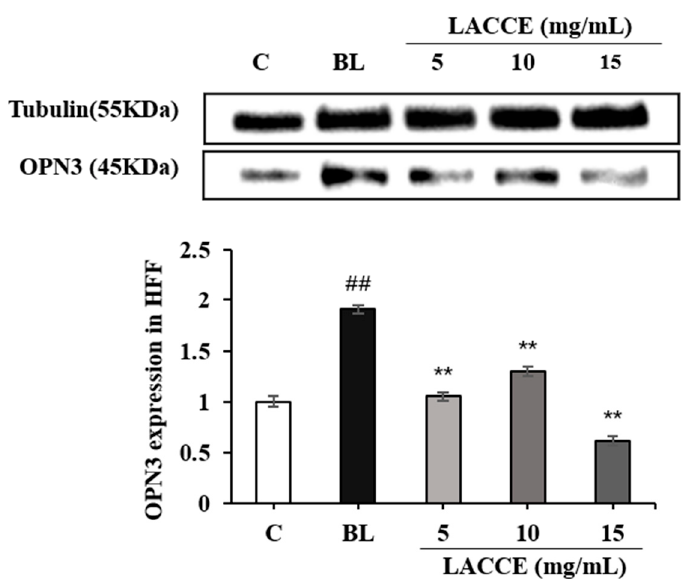
Figure 8. Effects of different concentrations of LACCE on OPN3. The data are expressed as mean ± standard deviation (SD) of three independent experiments ( n = 3). The data were analyzed using one-way analysis of variance (ANOVA) followed by Tukey’s test. ## p < 0.01 vs. control group (C). ** p < 0.01 vs. blue light model group (BL).